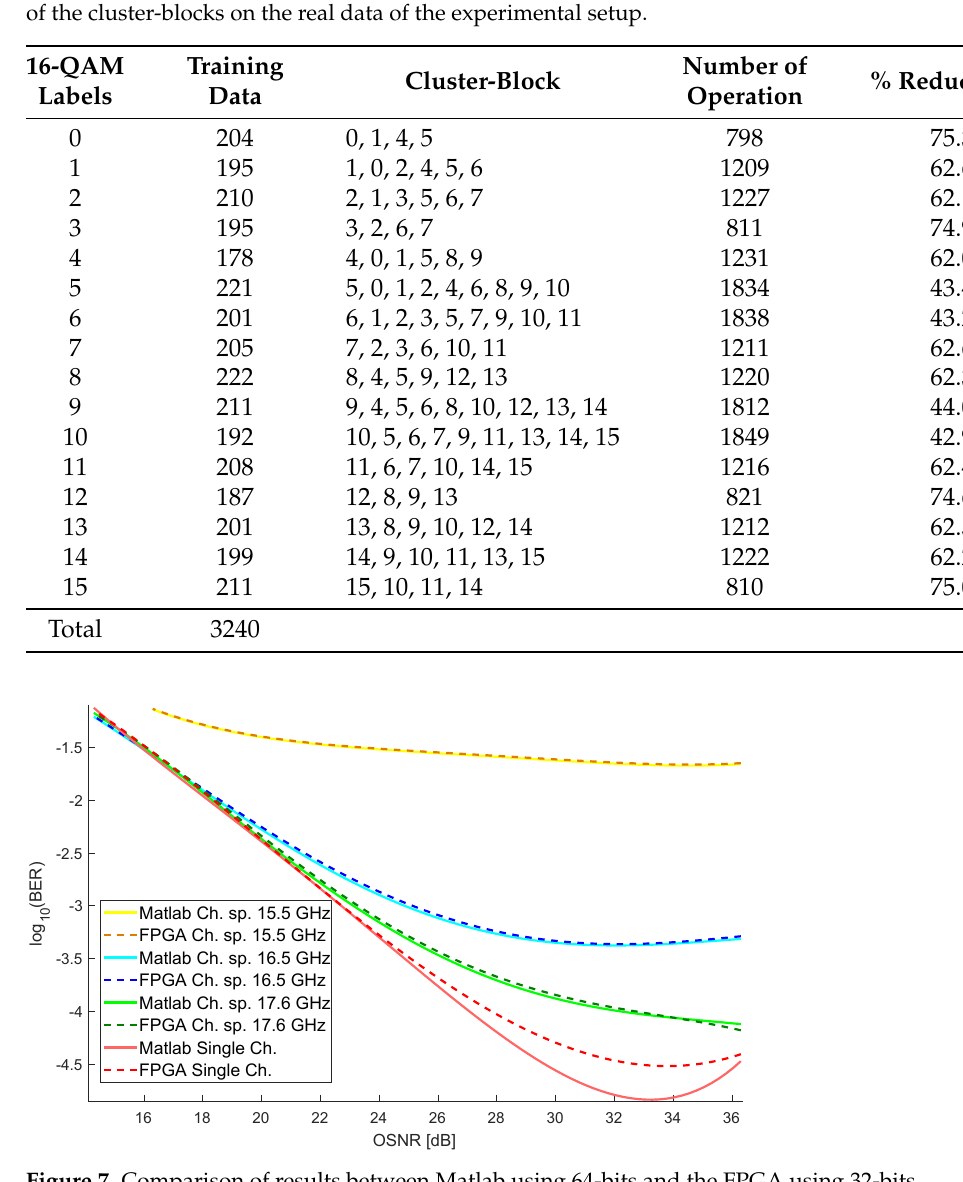
Figure 7. Comparison of results between Matlab using 64-bits and the FPGA using